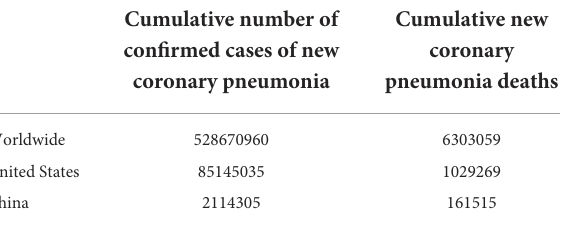
TABLE 1 Confirmed cases and deaths of new coronary pneumonia worldwide, USA and China.